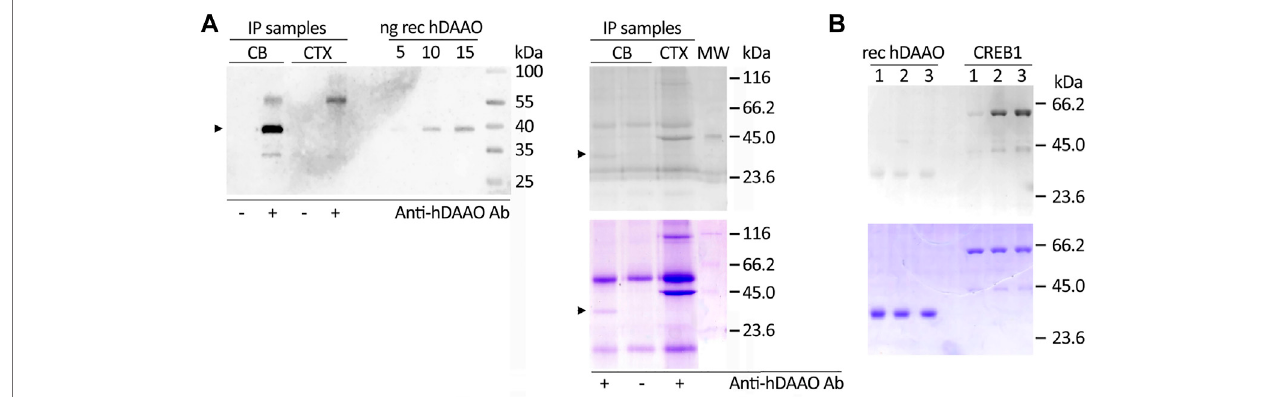
FIGURE 4 | Phosphorylation of hDAAO. (A) In the cerebellum hDAAO is phosphorylated. Left) The fl avoenzyme was immunoprecipitated from cerebellum lysates (CB) butnotfromcortexsamples(CTX), asveri fi edbyWesternblot. Right) The fl avoenzymephosphorylationlevelsweredetected bythePro-QDiamond GelStain (top panel) andtheidentityoftheobserved40 kDabandsfurtherveri fi edbyCoomassiebluestaining (bottompanel) ;inbothpanelsarrowheadsindicatethecorresponding hDAAO band. Immunoprecipitations performed eitheron cerebellumlysates intheabsenceofhDAAO antibodiesor on cortex lysates (where theprotein ispresent at trace levels) represented negative controls while diluted PeppermintStick Phosphoprotein Molecular Weight Standards (0.125 µg each protein, MW lane) were used as positive controls. The additional faint bands (at ∼ 55 and 30 kDa) observed in the left panel should correspond to the anti-hDAAO IgG heavy chain and to protein G, respectively. The bands present in right panel, in addition to the 40 kDa one corresponding to hDAAO, are aspeci fi c signals due to proteins interacting with the beads regardless of the presence of the crosslinked antibody. (B) In vitro phosphorylation experiments indicated that hDAAO is not modi fi ed by PKA. SDS-PAGE analysis of aliquots of the reaction mixtures containing 2 µg of recombinant hDAAO or 1.2 µg GST-tagged CREB1 as a positive control, collected at different times of incubation at 30 ° C (1 (cid:2) 0 min; 2 (cid:2) 2 h; 3 (cid:2) overnight). Upon resolution on a 12% acrylamide gel, phosphoproteins were detected by the Pro-Q Diamond Gel Stain (top panel) : while the 59-kDa band corresponding to CREB1 was positively stained, no detectable signal was apparent for the 40-kDa band corresponding to hDAAO. The amount of loaded proteins was veri fi ed by subsequently staining the gel in Coomassie blue (bottom panel)